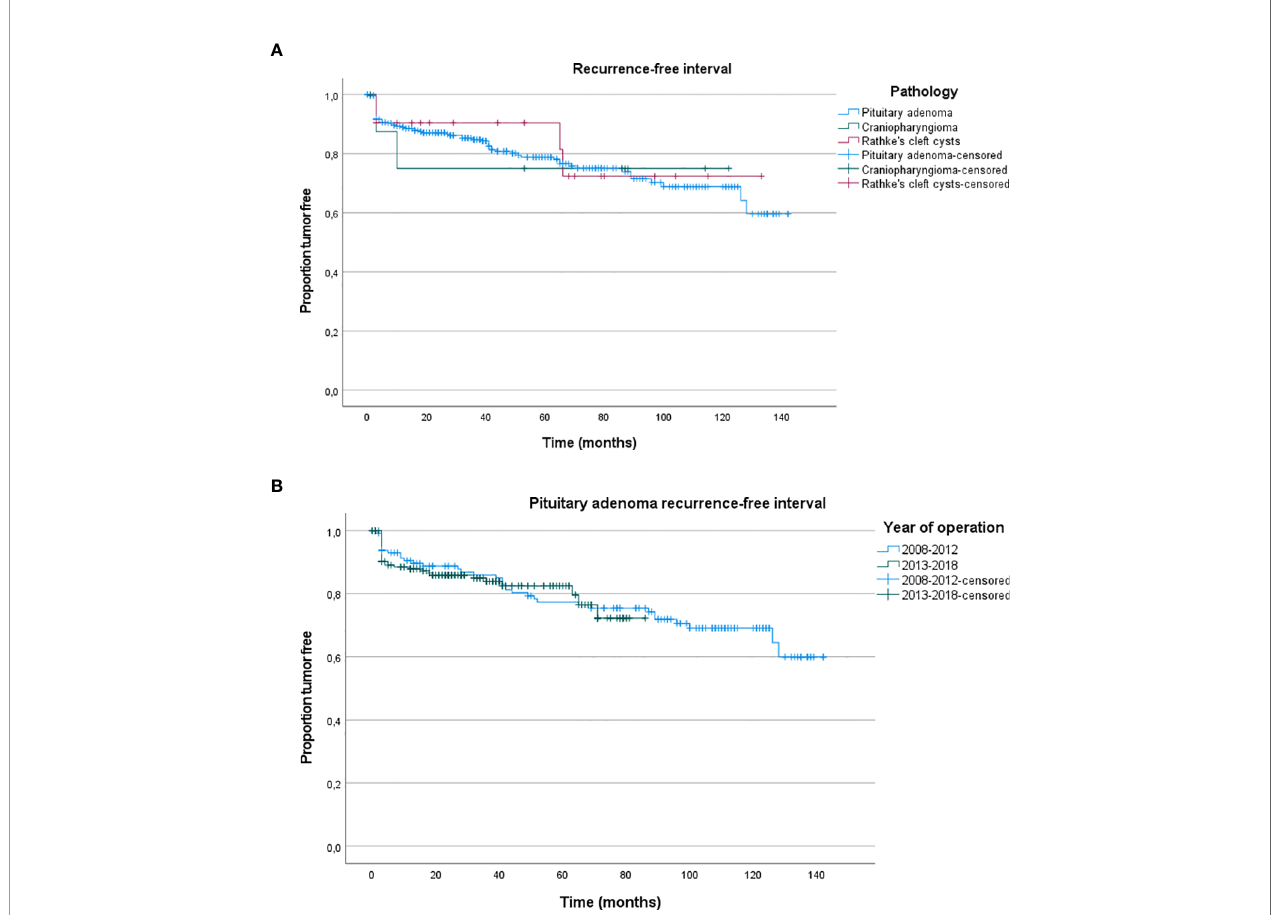
FIGURE 3 | (A) Kaplan – Meier recurrence-free interval curves for the three most frequent histological types. (B) Kaplan – Meier recurrence-free interval curves for the pituitary adenomas operated during the fi rst 5 years in comparison to the last 5